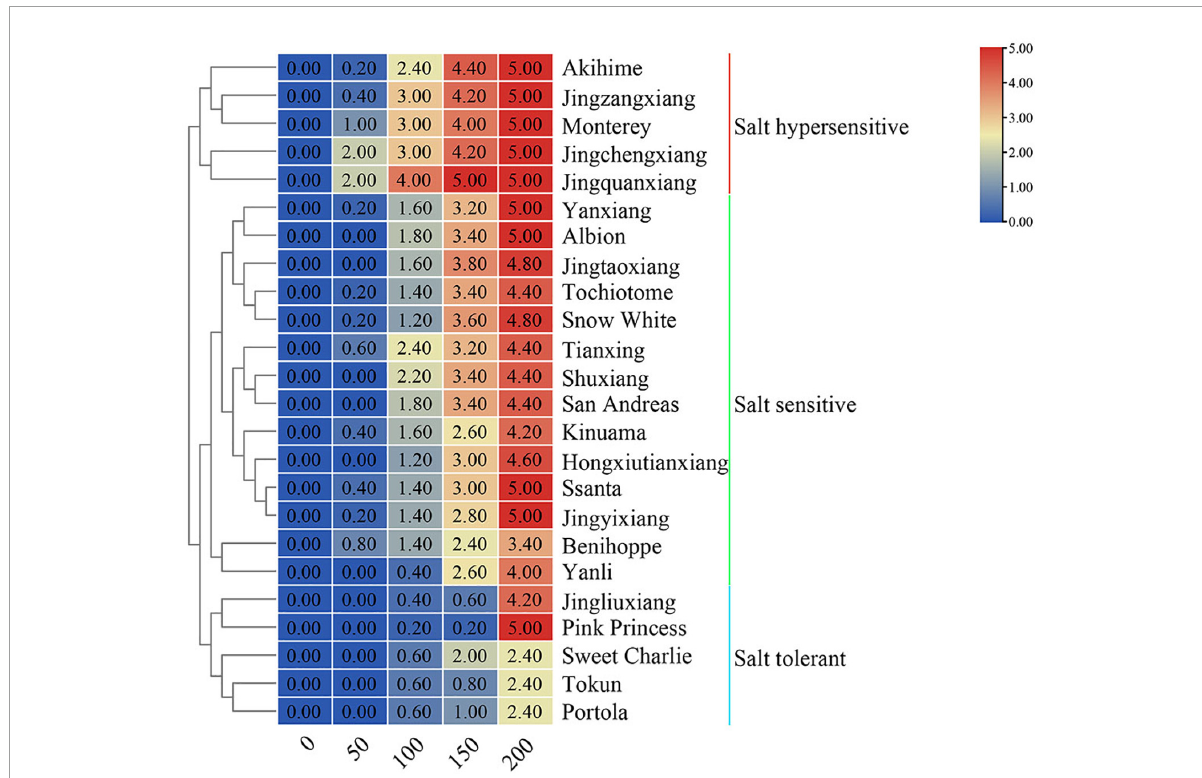
FIGURE1 Salt damage index of 24 strawberry varieties under different concentration of NaCl. Strawberry plants with 6–7 leaves were irrigated with five different concentrations of salt solutions: 0, 50, 100, 150, or 200 mM NaCl for 50 days. The salt damage index grades were scaled into six levels from 0 to 5, according to different damage symptoms in the leaves after salt treatment. Based on the salt damage indices, tested varieties were clustered into three groups: salt tolerant, salt sensitive, and salt hypersensitive.